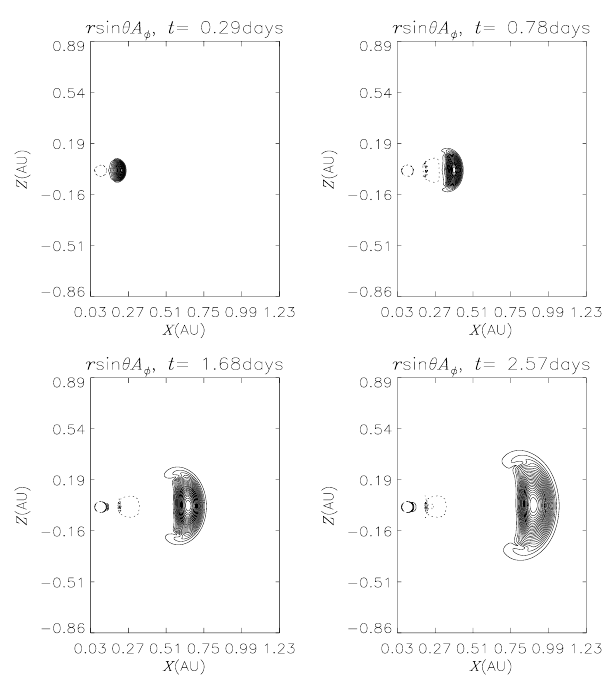
Fig. 3. The magnetic field lines of the ICME projected onto the r − θ plane for a case where the initial ICME moves at twice the solar wind speed. The four panels show the magnetic field at four different times in the outward journey.